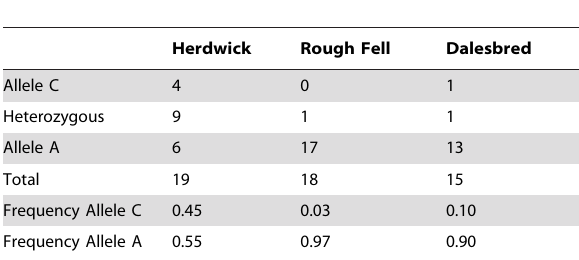
Table 3. Genotype classes and frequencies of alleles for SNP locus OAR16_41943180 (reproductive traits).